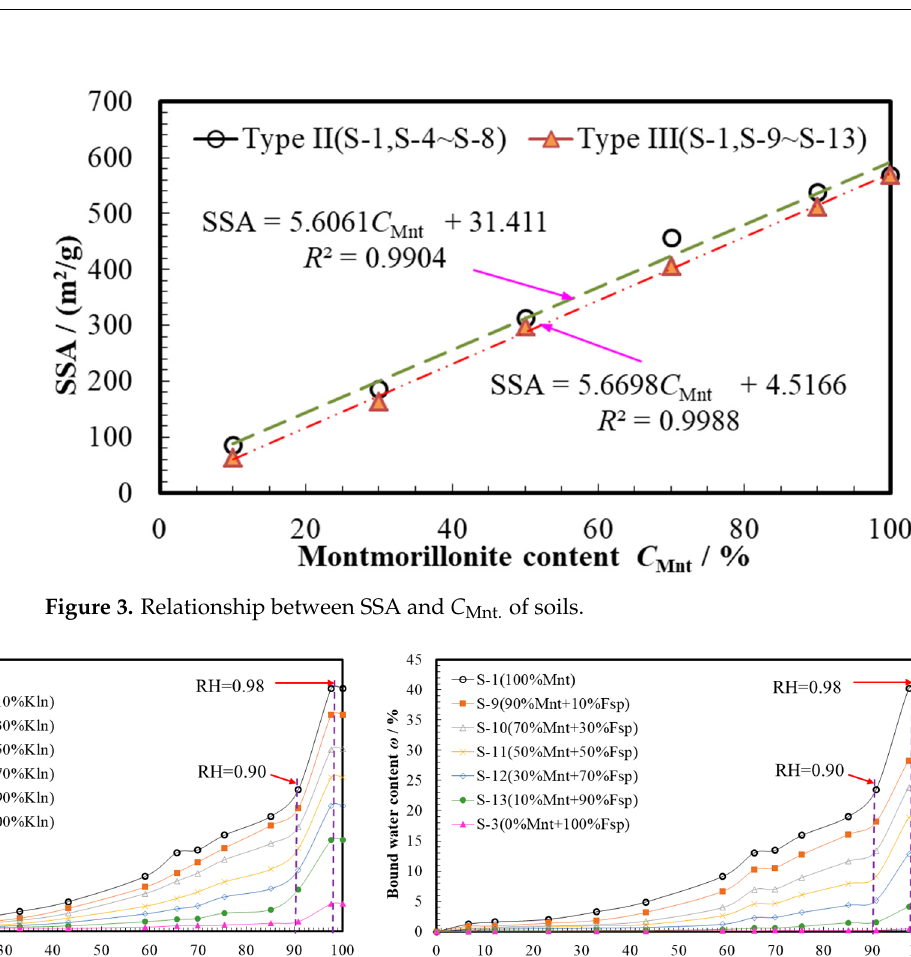
Figure 4. Isothermal adsorption curves of mixed clayey soils. ( a ) Type II (mixed soils with Mnt + Kln). ( b ) Type III (mixed soils with Mnt + Fsp).